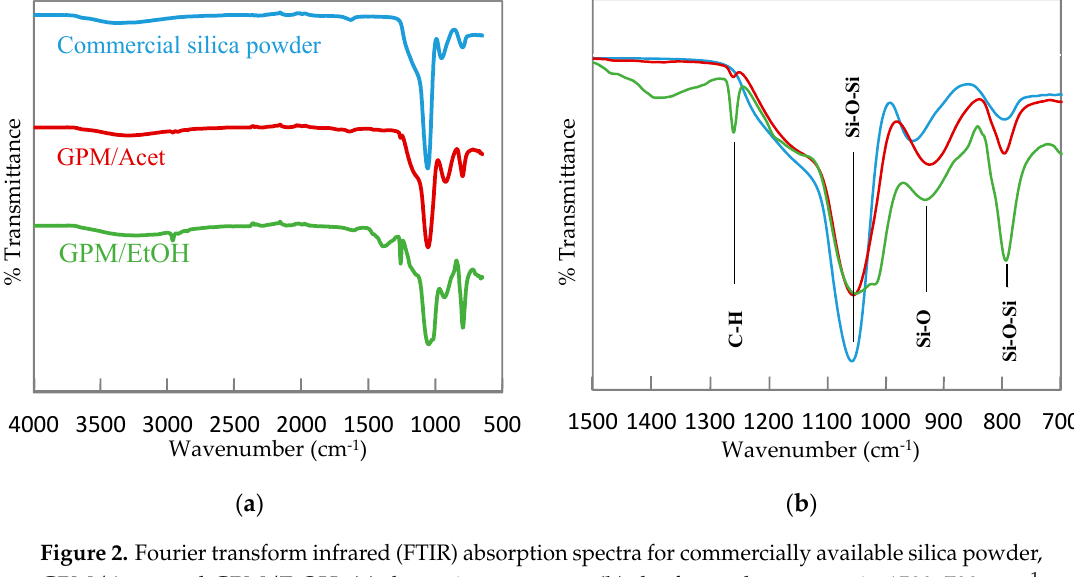
Figure 2. Fourier transform infrared (FTIR) absorption spectra for commercially available silica powder, GPM/Acet, and GPM/EtOH. ( a ) the entire spectrum; ( b ) the focused spectrum in 1500–700 cm − 1 wavenumber range.